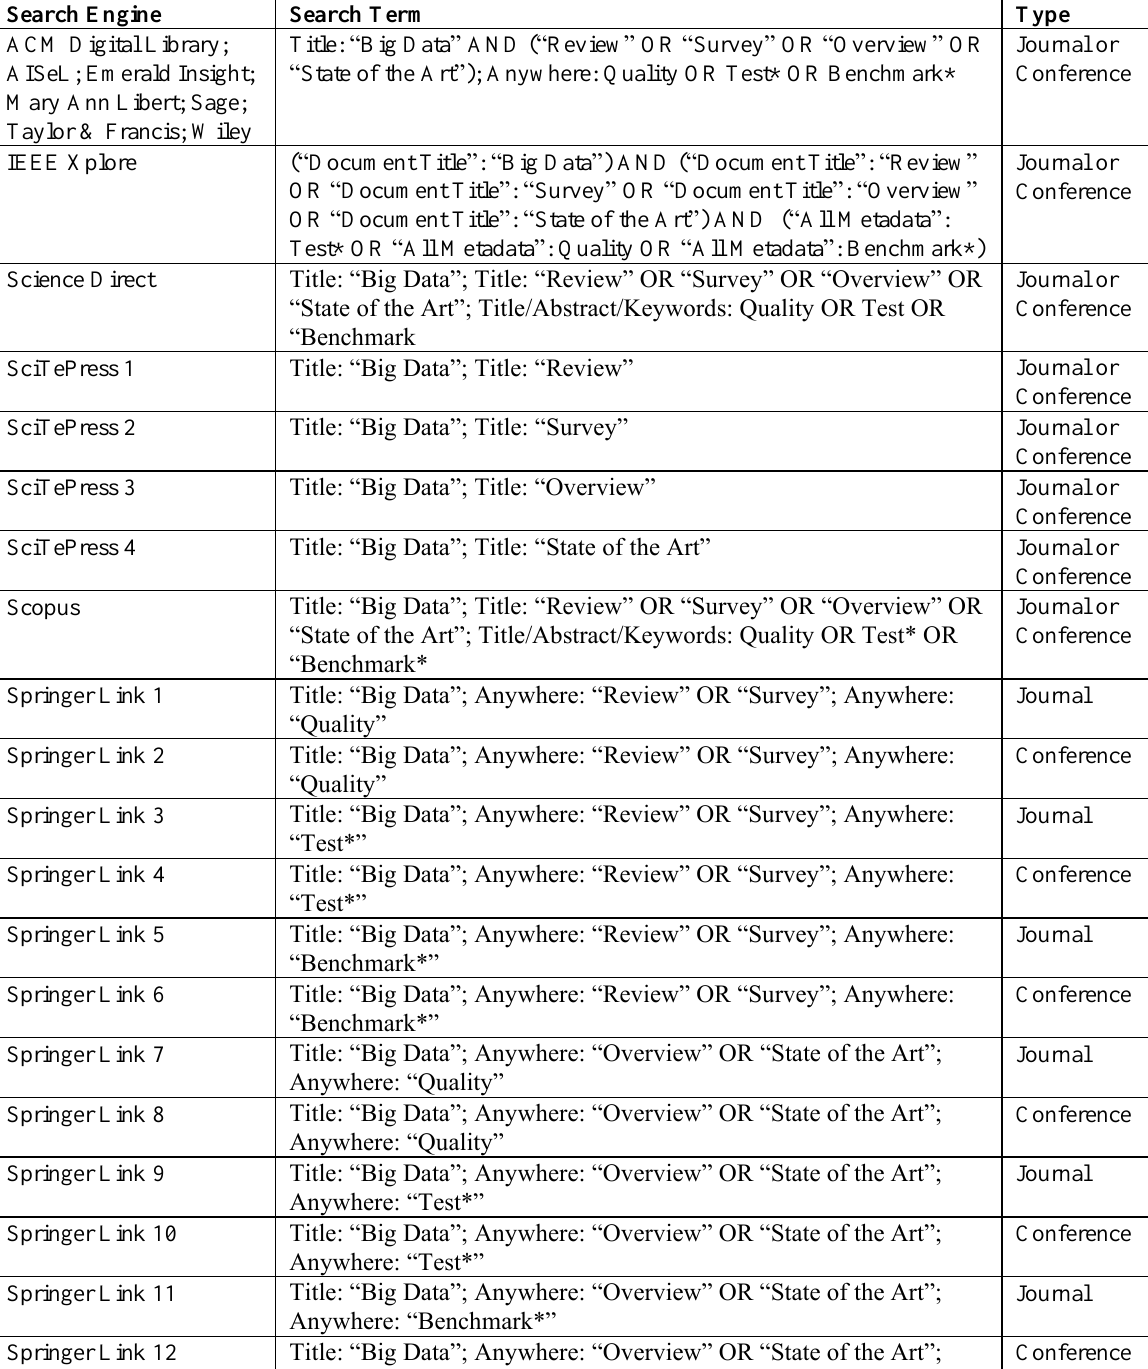
Table 1. Mapping of the Search Terms to the Used